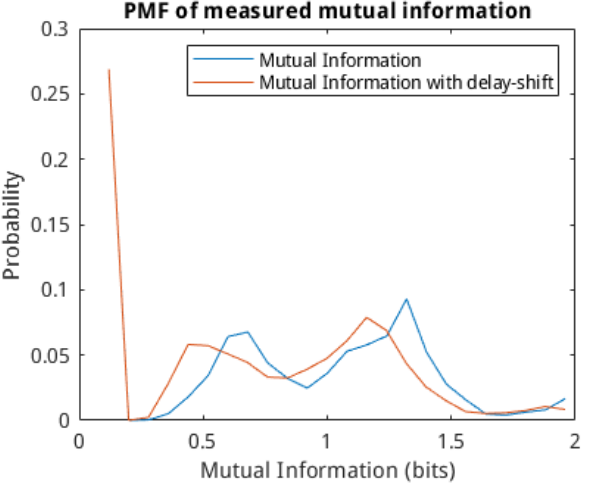
Figure 8. PMF plots of calculated mutual information for the measured spike-train (black) and the delay-estimate shifted spike-train